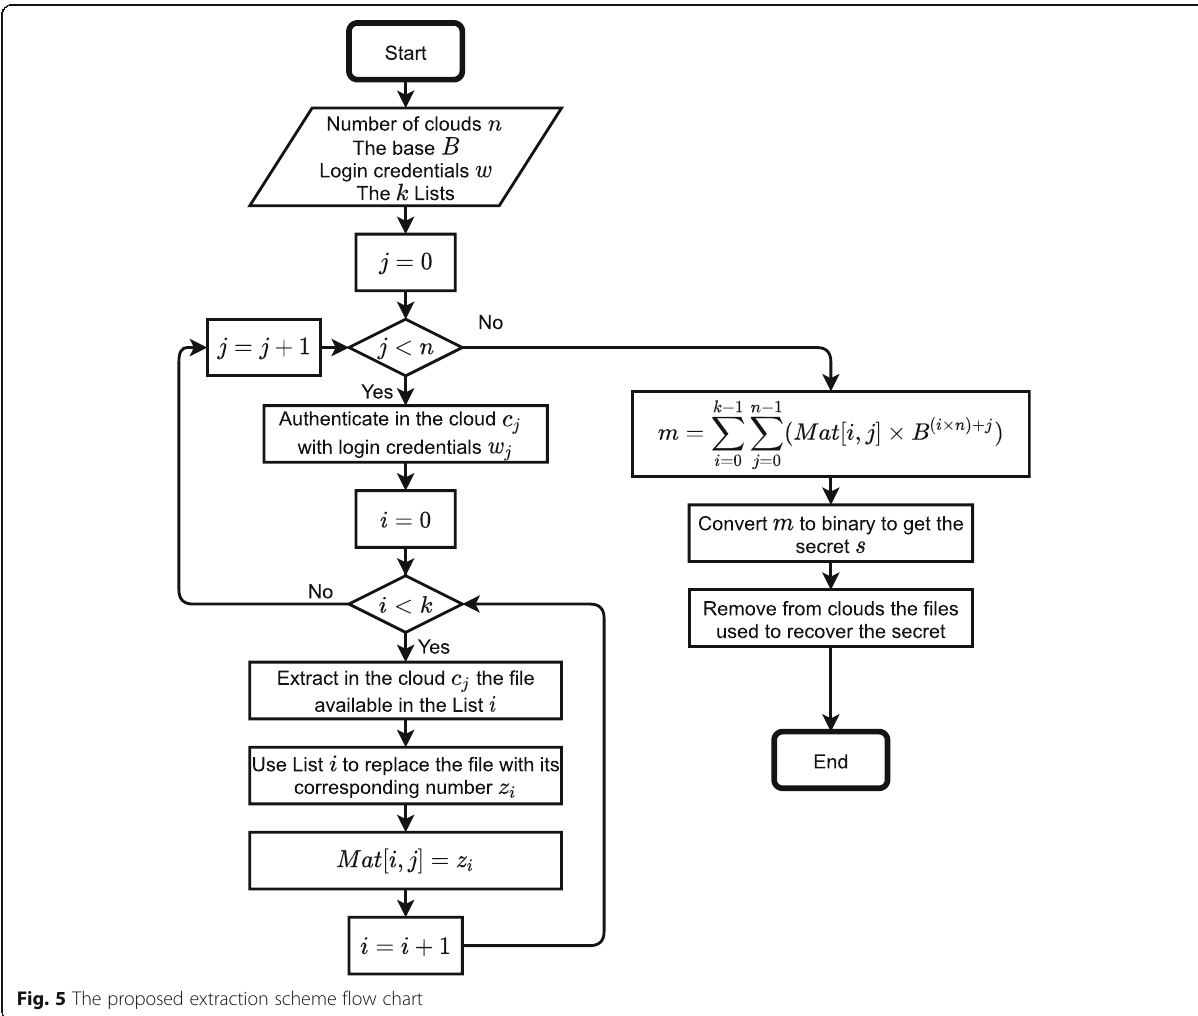
Fig. 5 The proposed extraction scheme flow